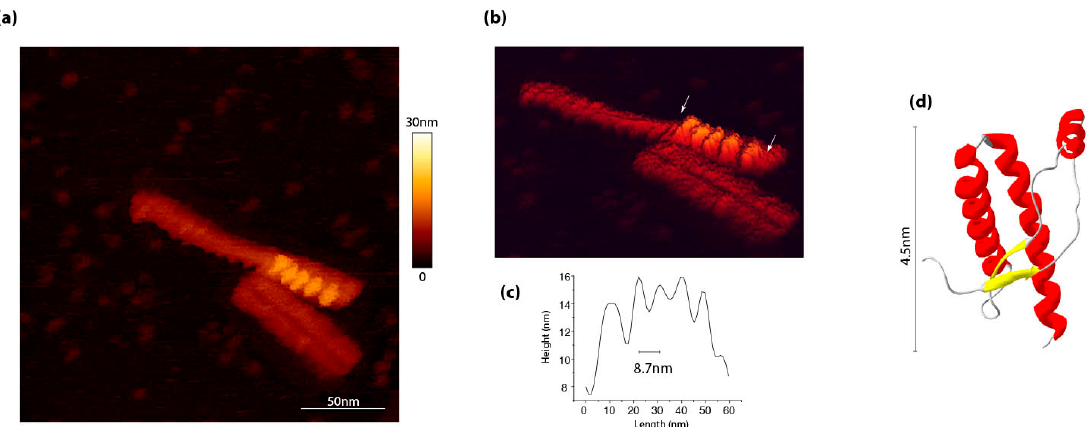
Figure 2. Motif repetition along PrP Sc assemblies, as identified by atomic force microscopy. ( a ) 263K PrP Sc assemblies purified according to a protocol by Wenborn et al. [52], as observed by atomic